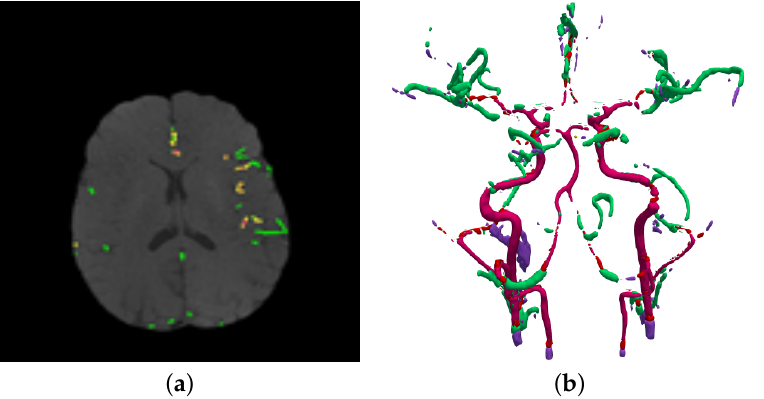
Figure 4. ( a ) Final result using 3D adaptive segmentation algorithm, ( b ) A 3D visualization of ( a ) using a growing tree